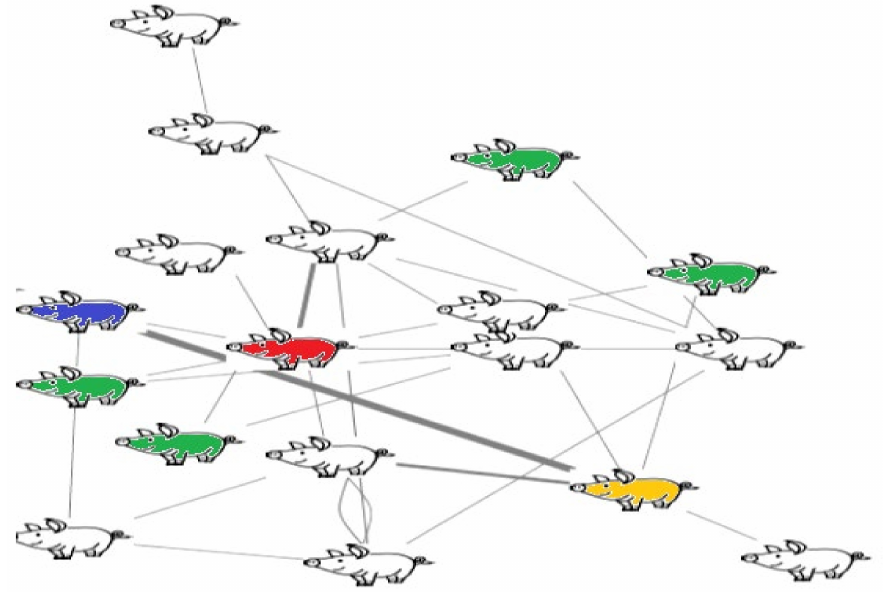
Figure 1. Example of a network. The pigs display the nodes, and the arrows display the edges. The thickness of the arrows represents the weight, i.e., the duration of the reciprocal fight. Red pig has the highest degree centrality, betweenness centrality, and closeness centrality in the pen. Yellow pig has the highest weighted degree centrality in the pen. Blue pig has the highest eigenvector centrality in the pen. Green pigs have the highest clustering coefficient in the